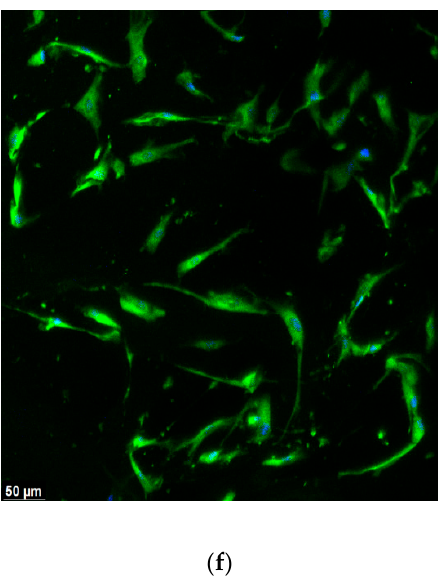
Figure 2. Fibroblast proliferation test with 20X magnification under confocal microscopy. ( a ) The fibroblast proliferation test revealed a significant difference between Jason and BioMend Extend membrane (*, p = 0.04), while there were no significant differences found between Jason and GENOSS membranes, and GENOSS and BioMend Extend membranes. Following the loading of HGF on membrane surfaces for 3 days, the positive control polyethylene terephthalate membranes ( b ) displayed an even dense proliferation of spindle shaped HGF across the entire membrane surface, while the negative control polyethylene terephthalate membranes ( c ) displayed poor HGF proliferation. Jason membrane ( d ) and GENOSS Collagen membrane ( e ) displayed dense and wide proliferation of HGF across the membrane surfaces, while Biomend Extend membrane ( f ) displayed uneven and scattered proliferation of HGF.